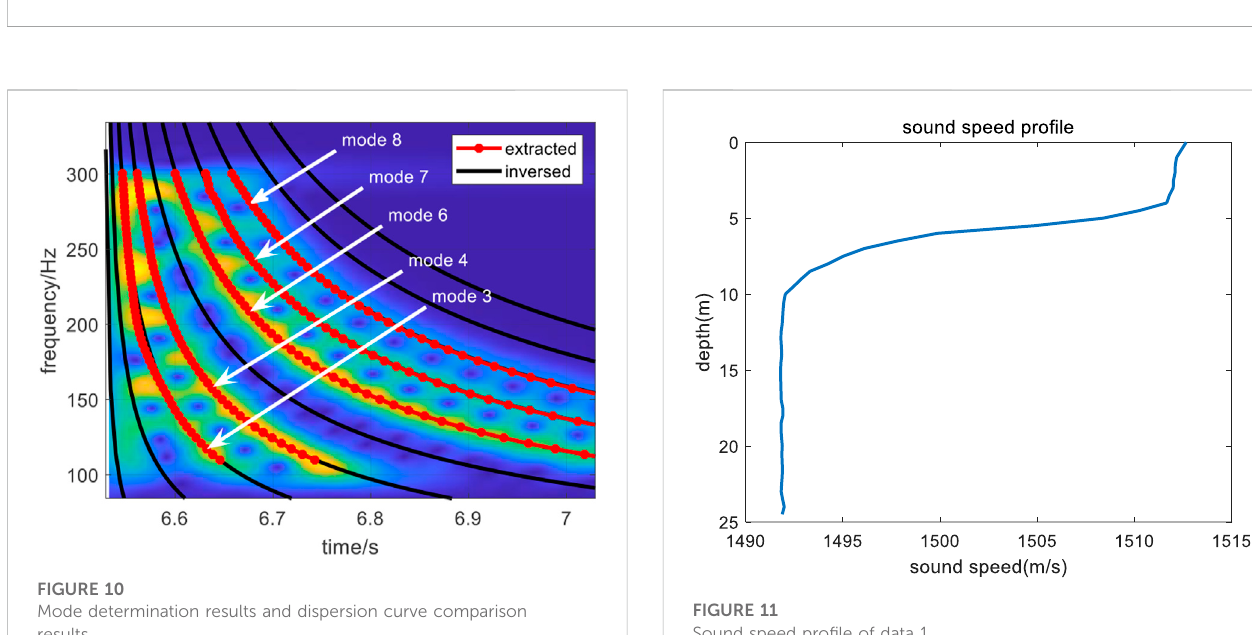
FIGURE 10 Mode determination results and dispersion curve comparison results.